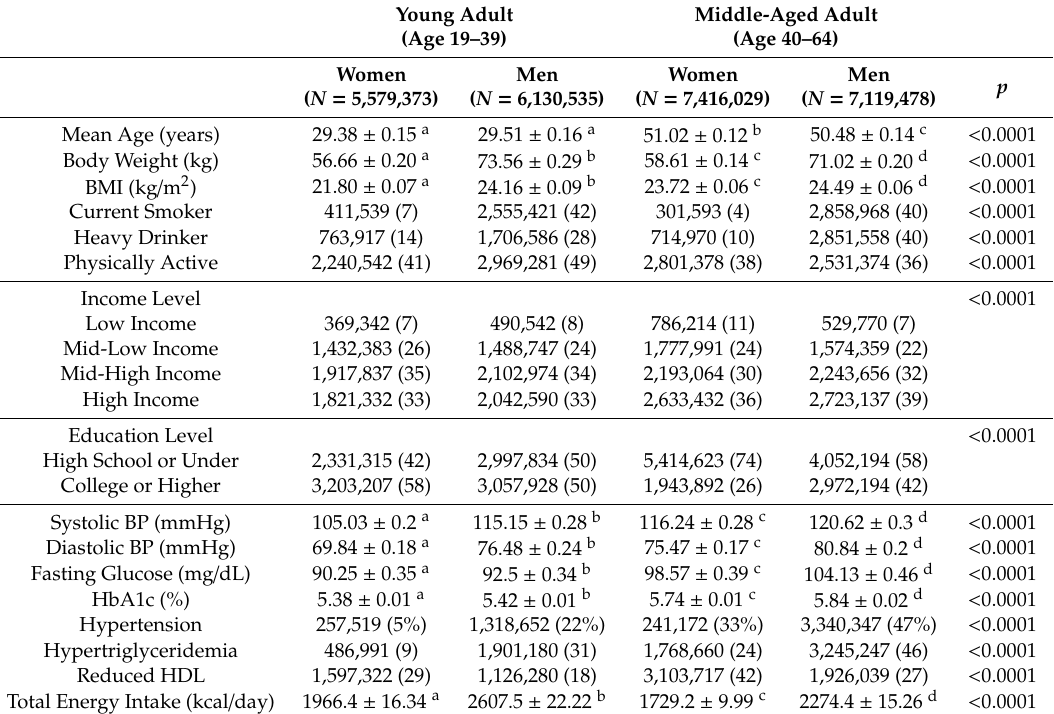
Table 1. Baseline